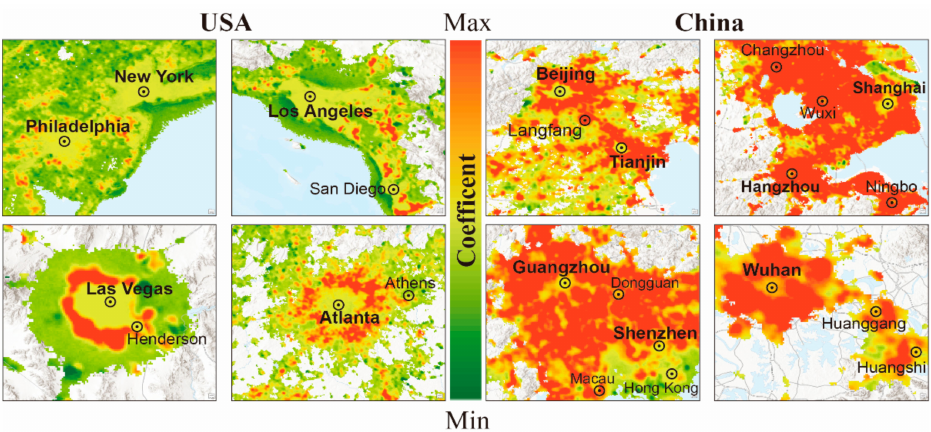
Figure 14. Comparison of LICC between Chinese and American Cities.